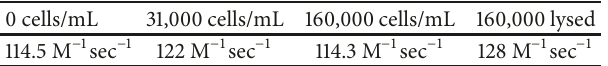
Table 3: The variation of the MC-LA second order rate constant in the presence of M. viridis